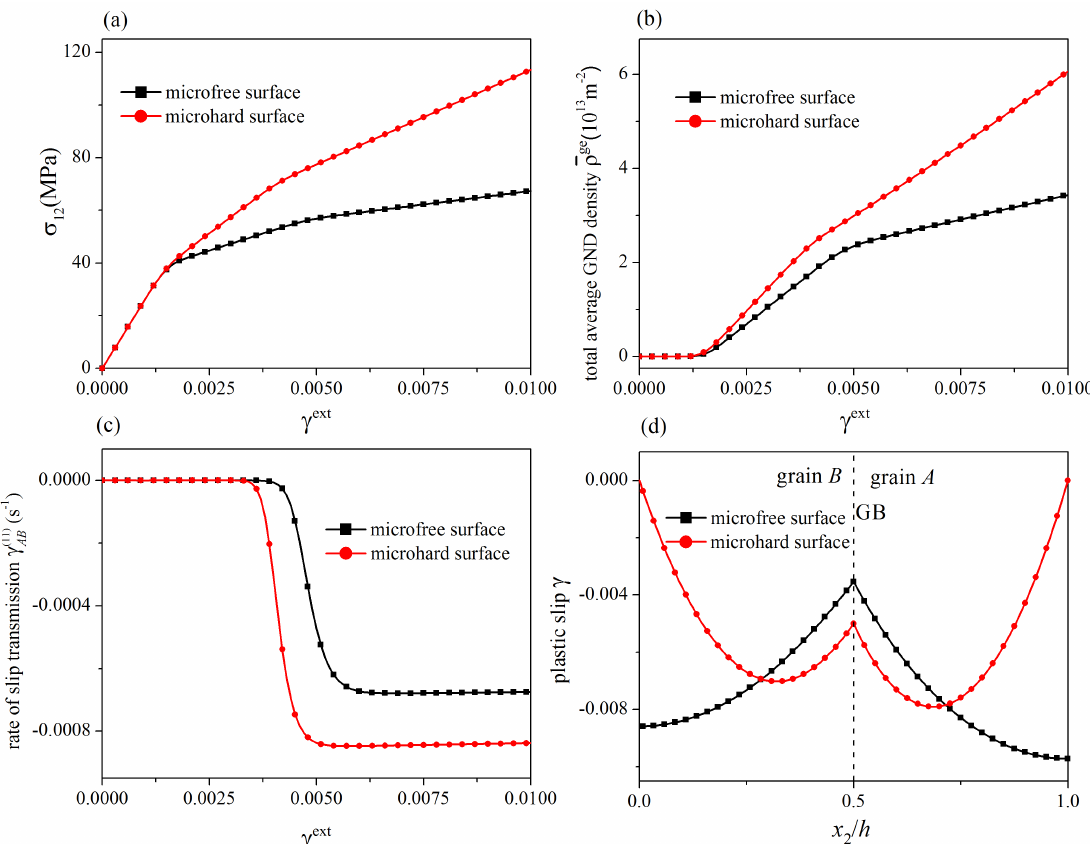
Figure 9. Influence of surface constraint: ( a ) stress-strain curves; ( b ) total average GND density; ( c ) the rate of slip transmission; ( d ) distribution of plastic slip at γ ext = 0.01. Dislocation absorption by surfaces and slip transmission may compete with each